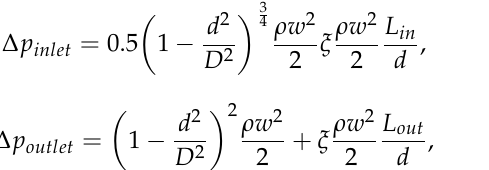
253035 Figure 5. Wall temperature in the T4 thermocouple section versus heat flux density. Based on the obtained data, the heat transfer coefficients for the regimes of convective and boiling heat transfer were calculated using h boil = q /( T w − T l ) and h con = q /( T w − T s ), where T w , T l , and T s are the wall, liquid, and saturation temperatures, respectively. The HTC obtained before the tube modification was then compared to the HTC after modification. Figures 6–8 show the results of the effect of the modification on the HTC in nucleate boiling regimes for the mass flow rates G = 420, 800, 1260 kg/(m 2 s) obtained at reduced pressures of p r = 0.43 and p r = 0.56. The HTC with increasing heat flux density and mass flow rate increased as usual. A decrease in the HTC was observed upon reaching the pre- crisis values of the heat flux. As a result of the modification to the mini-channel, the nu- cleate boiling HTC increased. The greatest effect of the modification was observed at p r = 0.43 for the mass flow rate G = 1260 kg/(m 2 s) where the average increase in the HTC was 110% (Figure 8a). The average increase in the HTC for mass flow rates G = 420 kg/(m 2 s) (Figure 6a) and G = 800 kg/(m 2 s) (Figure 7a) were 65% and 100%, respectively.